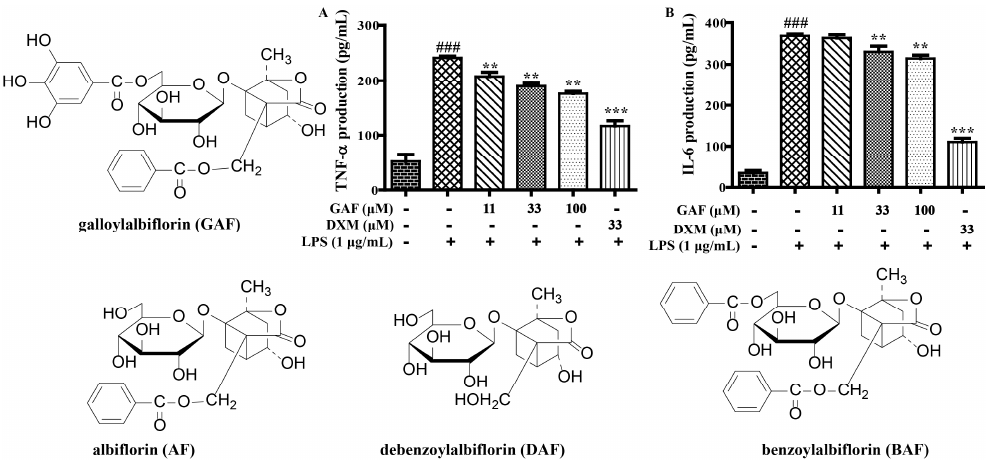
Figure 4. The effect of GAF on production of TNF- α and IL-6 in LPS-induced RAW 264.7 cells. The cells were treated with different concentrations of GAF (0, 11, 33, and 100 μ M) for 2 h, and were then stimulated with or without LPS (1 μ g/mL) for 12 h. The culture medium was collected to detect the production of TNF- α ( A ) and IL-6 ( B ), which were measured using Elisa kits. ( ### p < 0.01 vs . control group; ** p < 0.01, *** p < 0.001, vs. LPS group). AF, BAF and DAF presented no obvious activities at the tested concentrations.